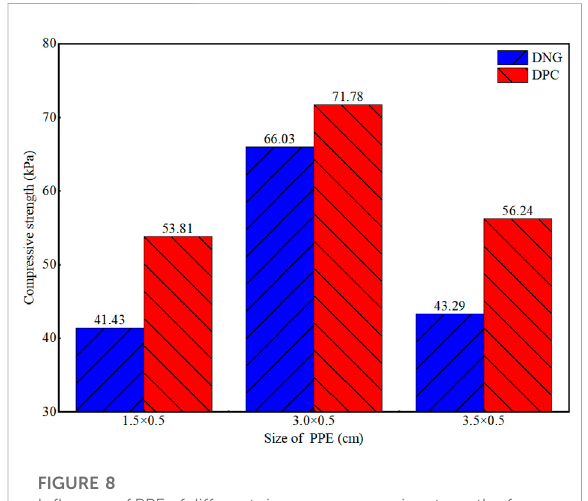
FIGURE 8 In fl uenceofPPEofdifferentsizesoncompressivestrengthof mixed samples.